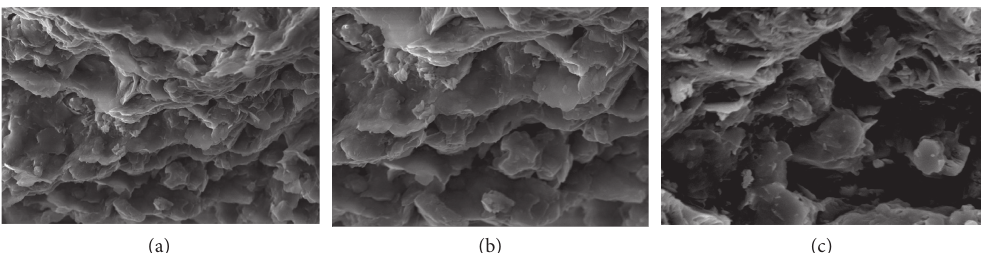
Figure 10: Crack development of the sample with different pH values’ solution after four-time cyclic drying-wetting (5000 times larger). (a) pH � 7, (b) pH � 5, and (c) pH � 3.